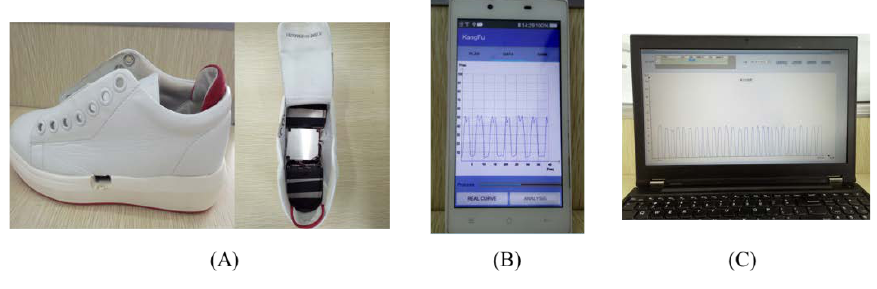
Figure 6. Testing system: ( A ) Plantar pressure testing device; ( B ) App; ( C ) Doctor interface.